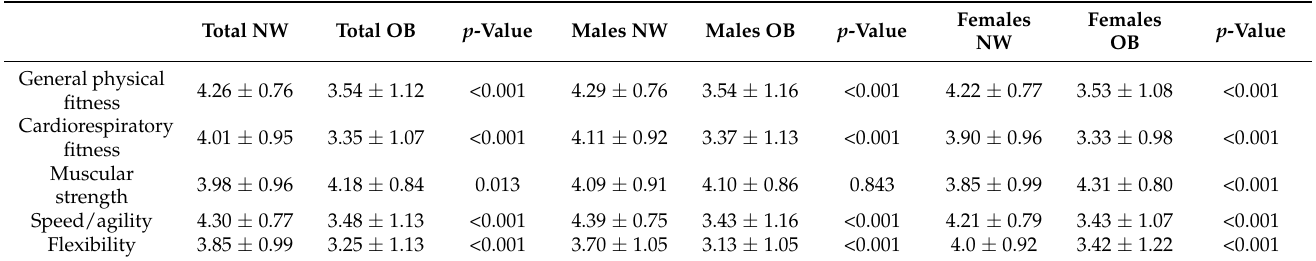
Table 3. Differences for each International Fitness Enjoyment Scale item.